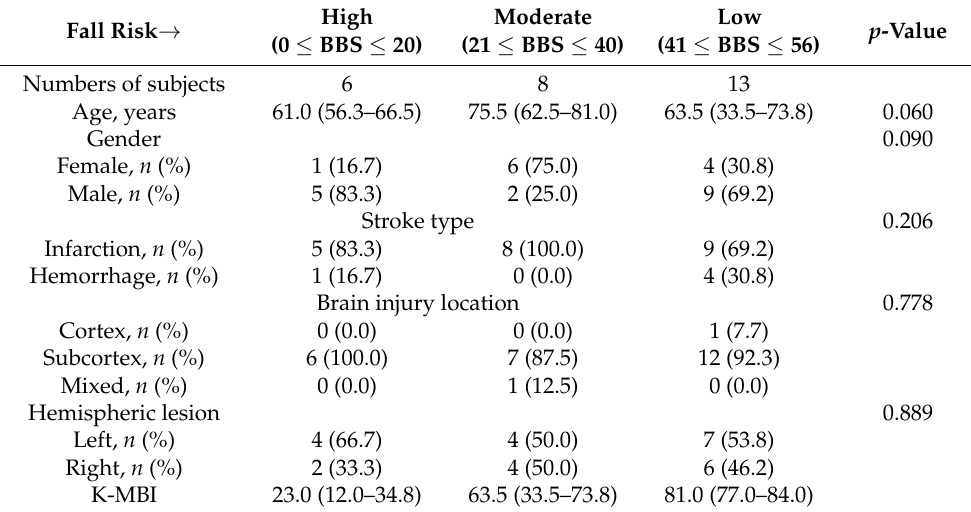
Table 1. Participants’ demographic